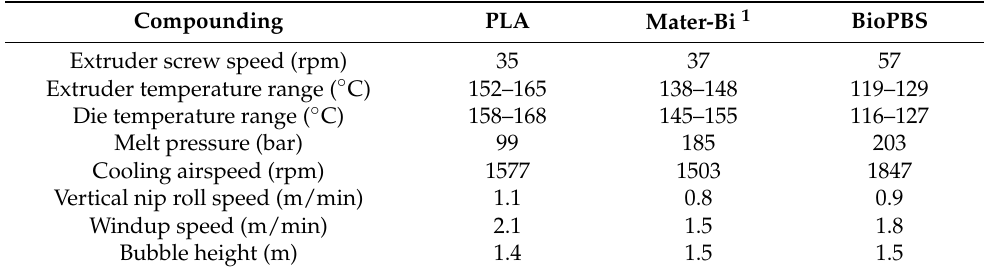
Table 16. The 2nd and 3rd film generation optimal blowing